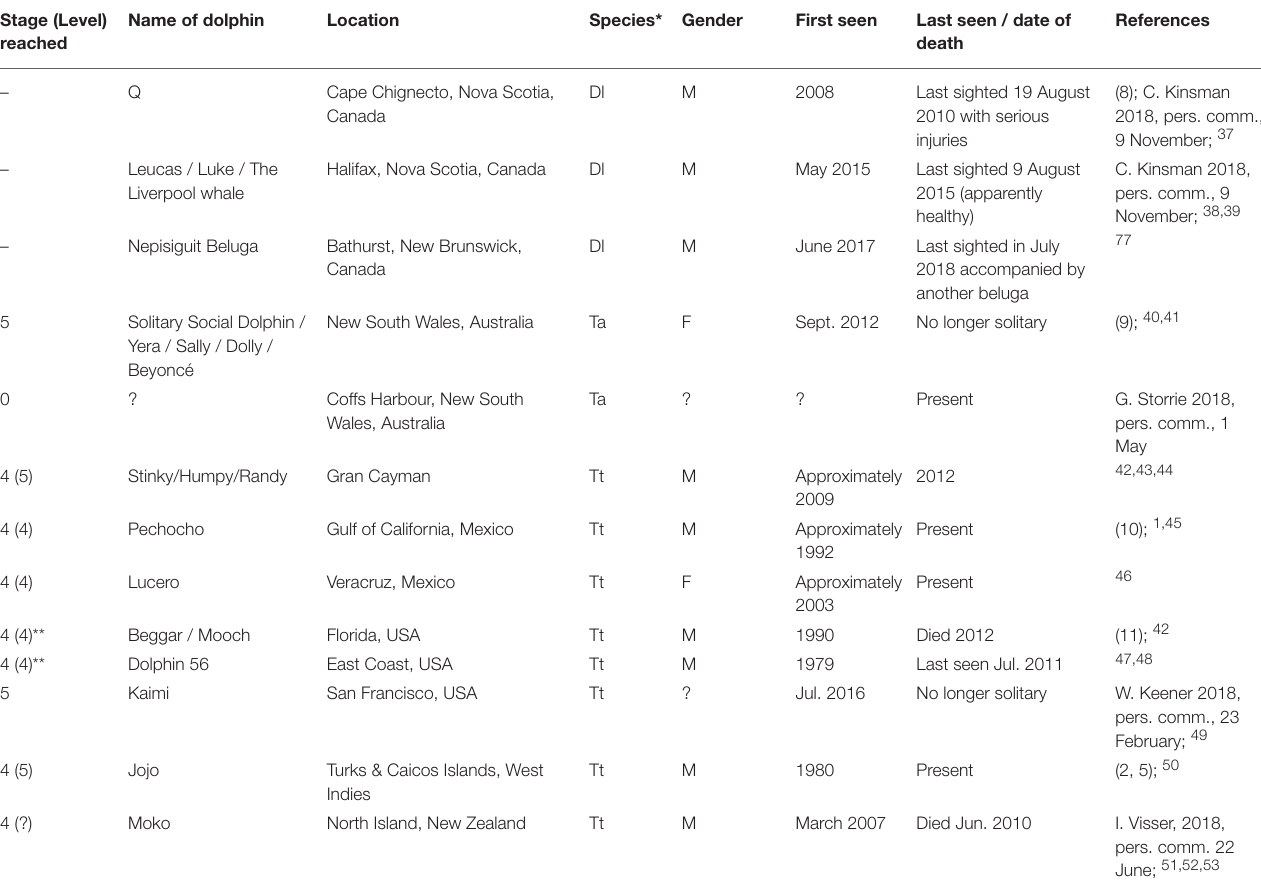
TABLE 3 | Solitary and solitary-sociable dolphins in the rest of the world since 2008. Stage (Level) Name of dolphin Location Species* Gender First seen Last seen / date of reached